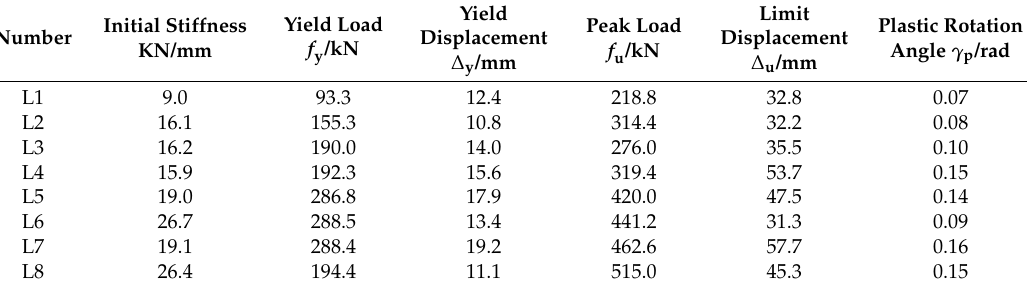
Figure 11. Skeleton curve of loading displacement of each test specimen. Table 5. Mechanical properties of the specimens.